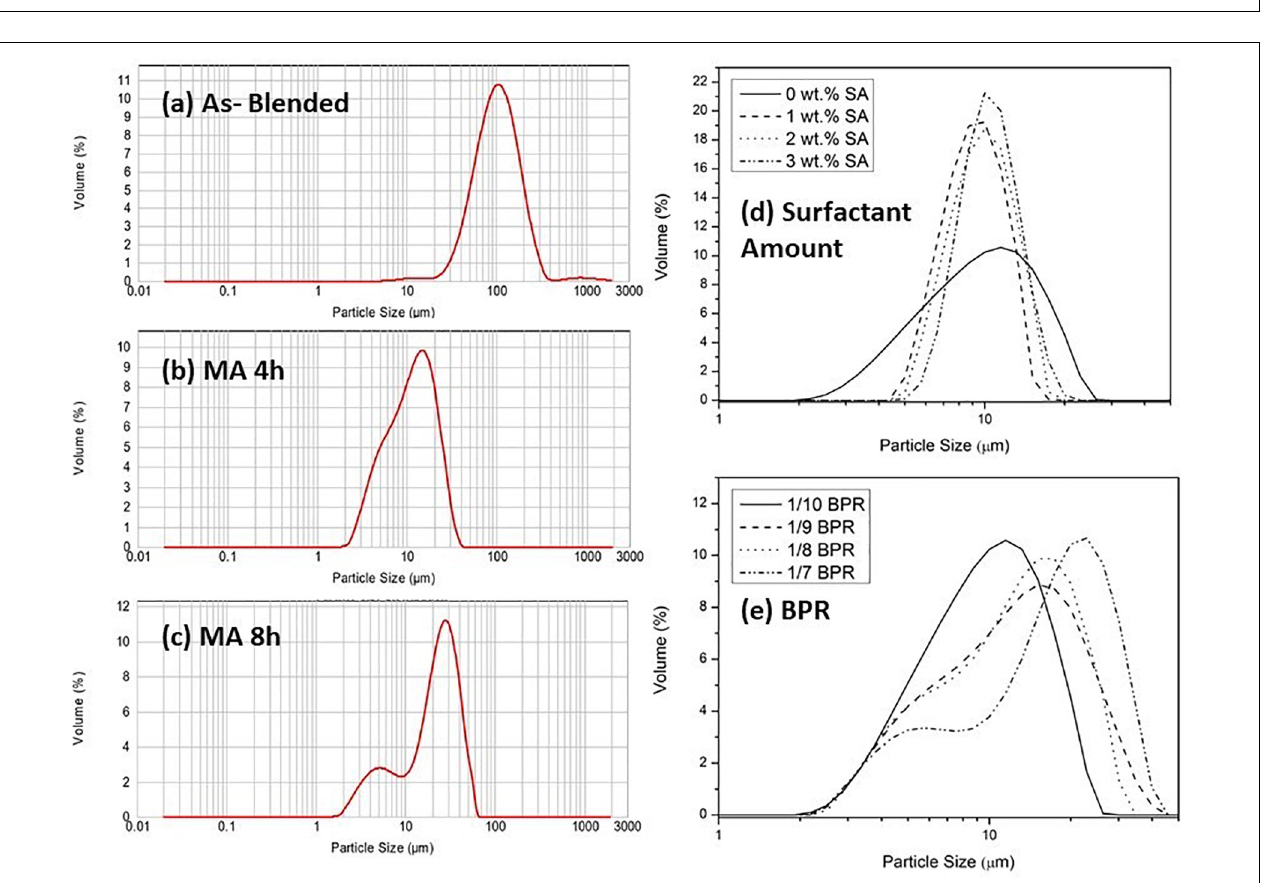
FIGURE 2 | Particle size analysis as a function of MA parameters: (a) As-blended powders (MA 0 h), (b) MA 4 h, (c) MA 8 h, (d) surfactant amount and (e) ball to powder ratio (BPR) (modified after Söyler et al., 2010, 2011).